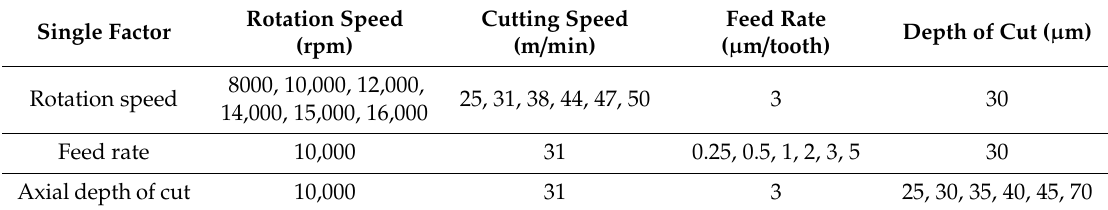
Figure 1. Experimental set-up for milling Zr-based bulk metallic glass (BMG). ( a ) Rough milling platform; ( b ) micro milling platform; ( c ) the two-tooth micro tool. Table 1. Experimental parameters of micro milling Zr-based bulk metallic glass (BMG).